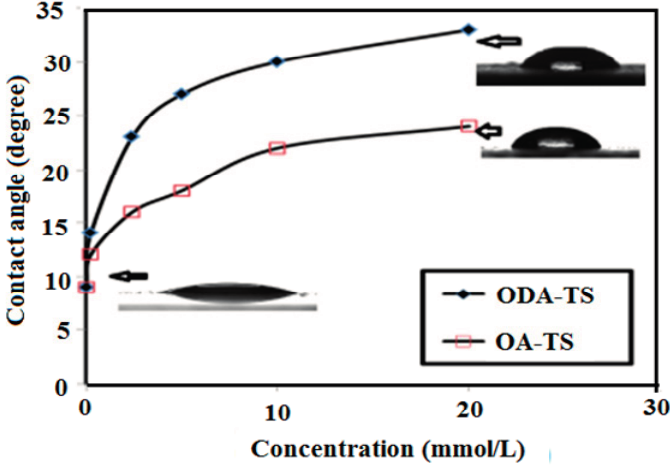
Figure 7. Relation between contact angle measurements and concentrations of OA-TS and ODA-TS in 1 M HCl aqueous solutions at steel